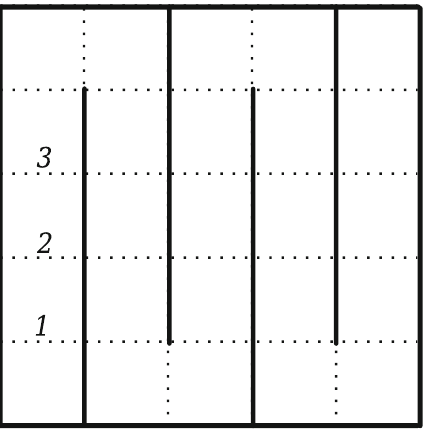
Fig. 5 Two-dimensional representation of the 5 × 5 lattice with peri- odic boundary conditions. The solid lines are fixed to the identity and the doted ones are integrated in the evaluation of the weight function ratio corresponding to a nonlocal plane